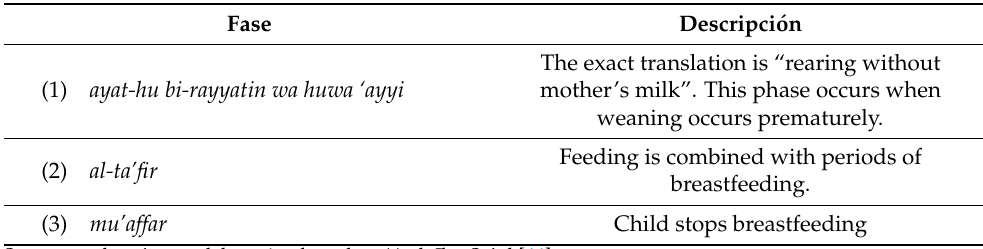
Table 4. Stages of weaning stipulated in the Muslim population. Fase Descripci ó